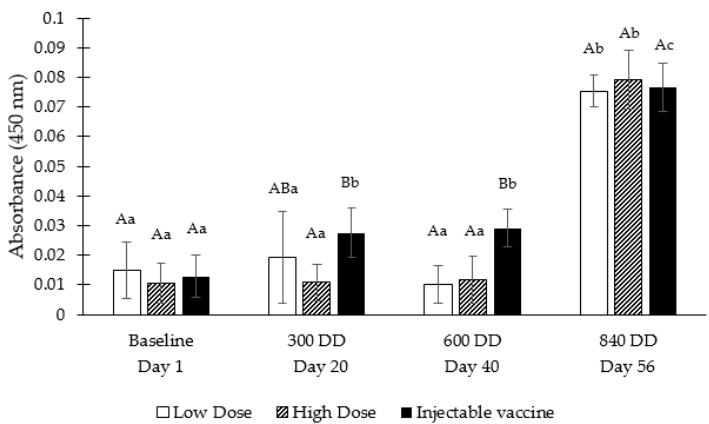
Figure 5. Serum Piscirickettsia salmonis -specific IgM levels of Atlantic salmon vaccinated with: oral vaccine low dose, oral vaccine high dose and injectable vaccine. Different capital letters indicate significant differences ( p ≤ 0.05) of the absorbance among the different experimental groups (low dose, high dose, injectable vaccine) within the same sampling point. Different lowercase letters indicate significant differences ( p ≤ 0.05) of the absorbance among the different sampling points (baseline, 300, 600 and 840 DD) within the same experimental group.